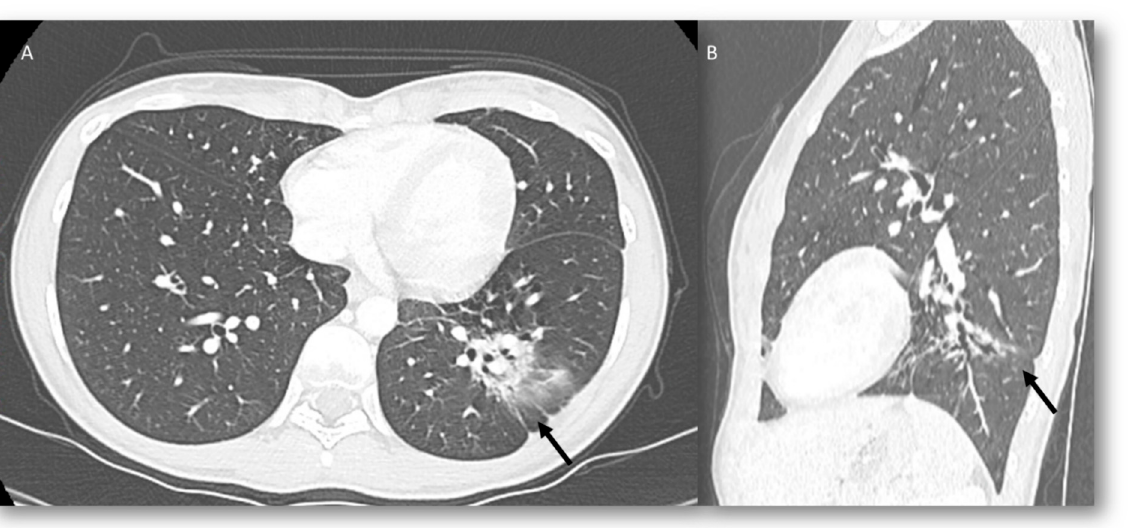
Figure 3. Graphical representation of the different pneumonia related to RT, considering the onset timing.